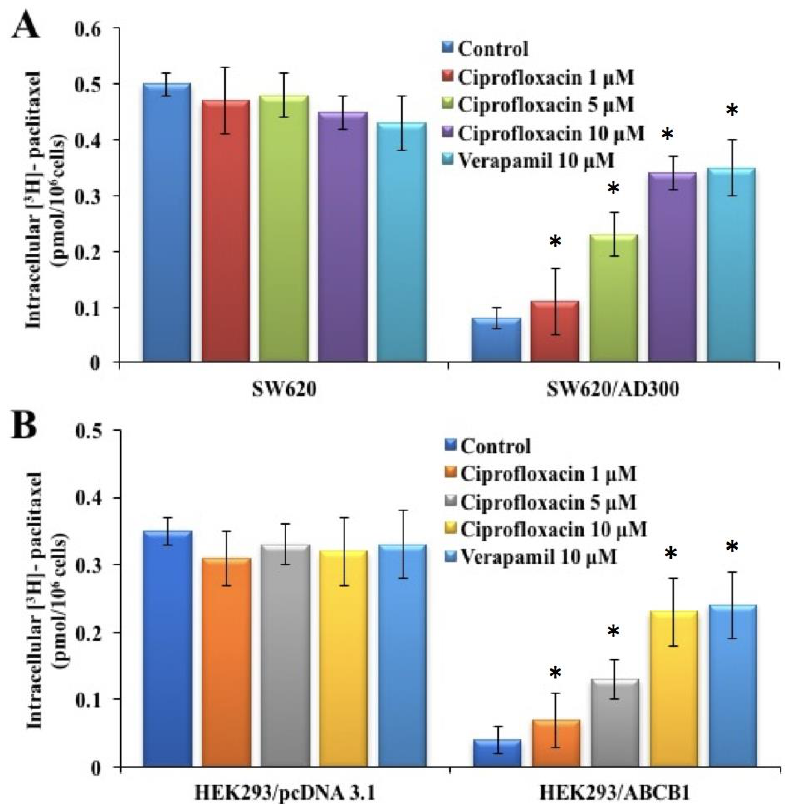
Figure 2. Effect of ciprofloxacin on the accumulation of [ 3 H]-paclitaxel. The effect of ciprofloxacin on accumulation of [ 3 H]-paclitaxel in SW620 and SW620/AD300 cells ( A ) and HEK293/pcDNA3.1 and HEK293/ABCB1 cells ( B ). Columns are the mean of triplicate determinations; the error bars represent the SD, * p < 0.05 versus the control group. Verapamil 10 µ M is used as positive control for ABCB1-overexpressing cells.